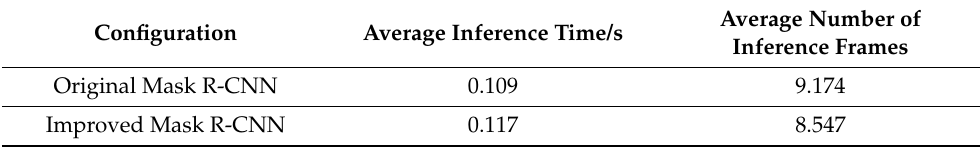
Table 2. Comparisons of time consumption before and after improvement.